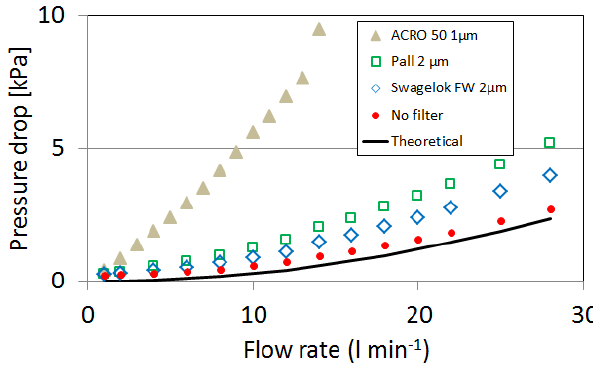
Figure 3. Pressure drop in the IRGA cell (kPa) as a function of the flow rate (Lmin − 1 ) for different filters: ACRO 50 (triangles), PALL 2µm (squares), Swagelok FW 2µm (diamonds) and without any filter (dots). The theoretical curve (Eq. 1) is given by the continuous line.